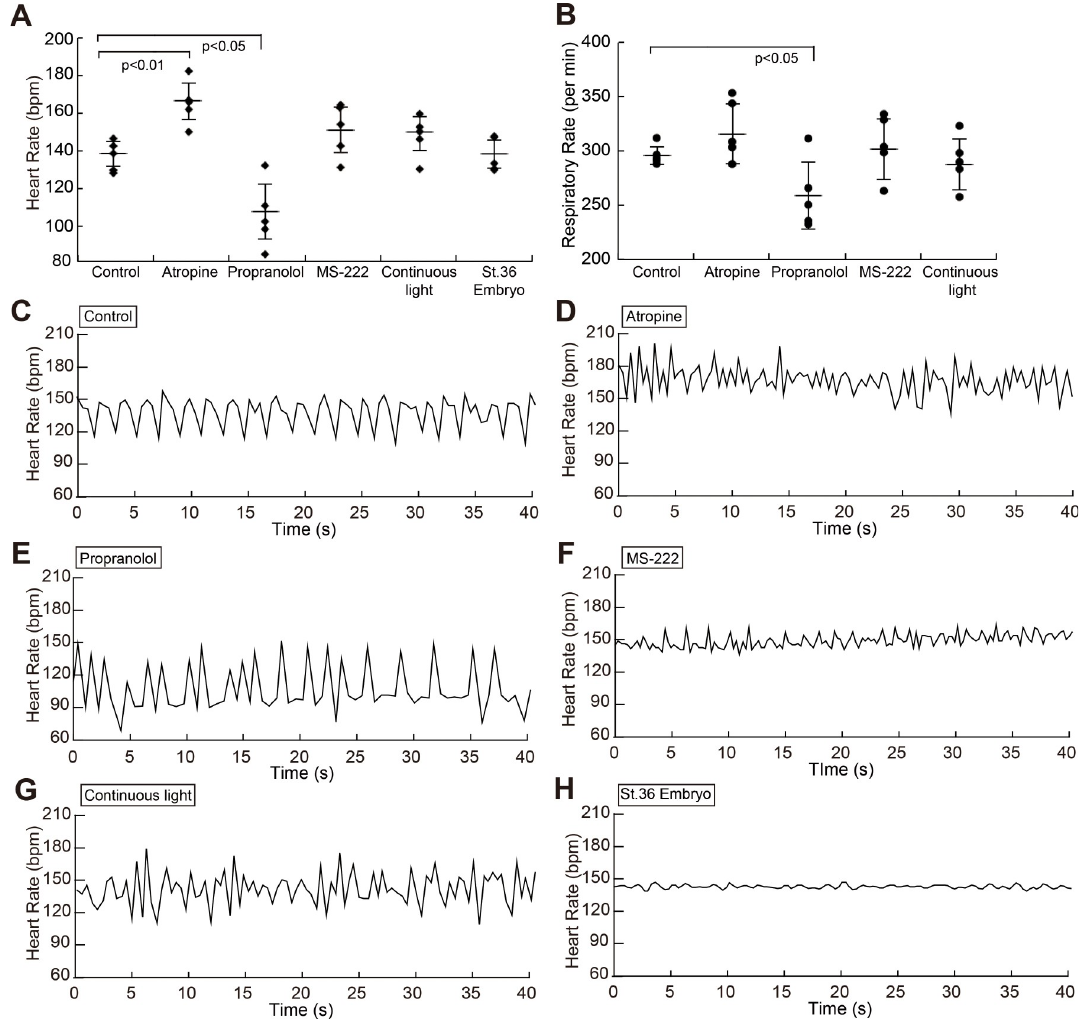
Fig 1. Average of steady-state heart rates, respiratory rates and examples of beat-by-beat heart rates. Group averaged steady-state heart rates were plotted under each condition (A). Group averaged respiratory rates (per min) were plotted under each condition in adult medaka (B). Standard deviations among five fish are plotted as error bars. Examples of beat-by-beat heart rate changes for 40 s under each experimental condition are presented (C-H). Control (C), 1 mM atropine (D), 100 μ M propranolol (E), anesthesia with 80 μ g/mL MS-222 (F), continuous light (G) and St. 36 embryo